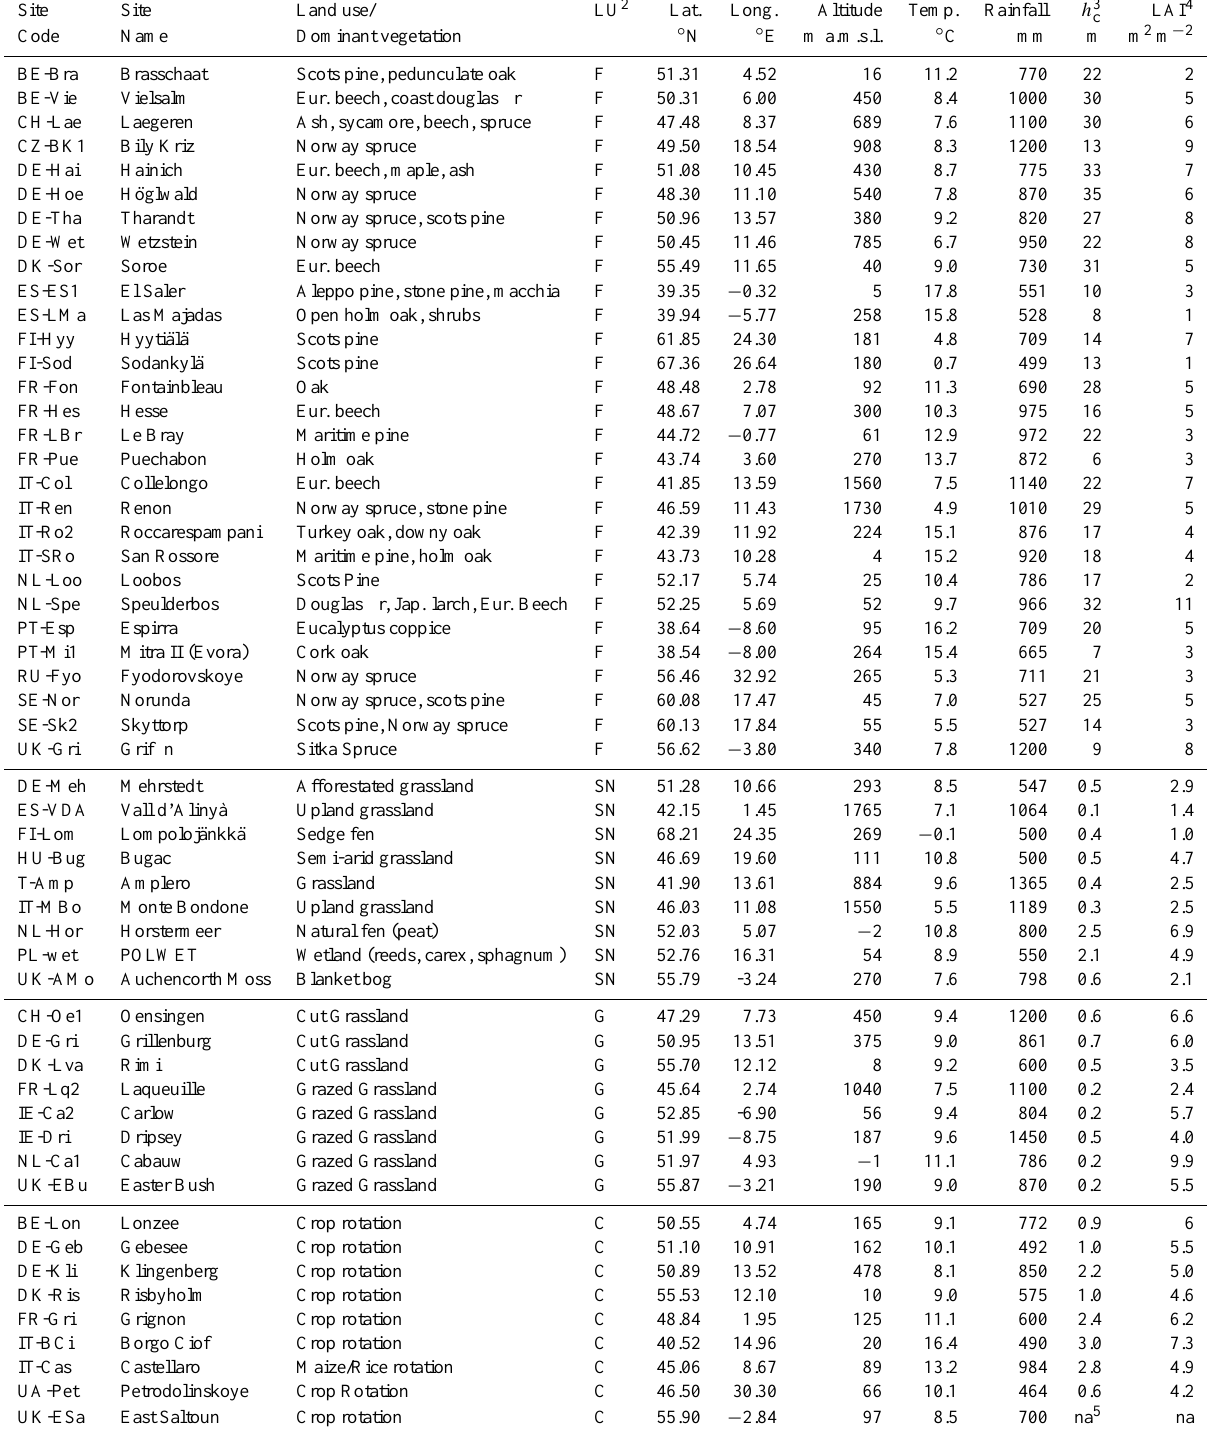
Table 1. NitroEurope inferential network monitoring sites 1